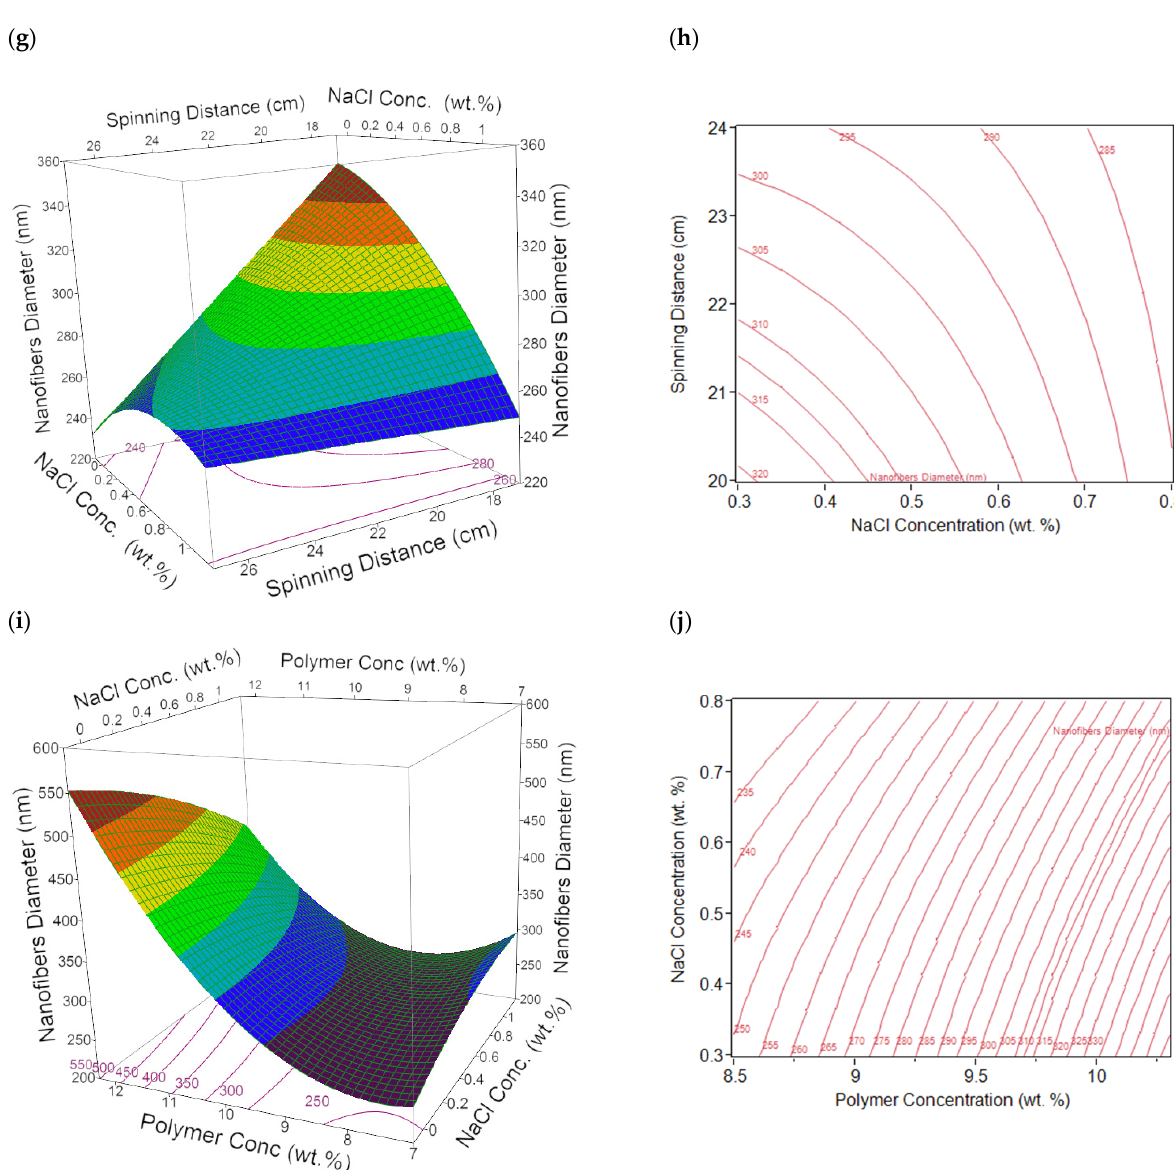
Figure 4. 3D response surface plots ( a , c , e , g , i ) and 2D contour plots ( b , d , f , h , j ) of interaction between the ( a , b ) applied voltage and spinning distance ( VD ); ( c , d ) spinning distance and polymer concentration ( DP ); ( e , f ) flow rate and polymer concentration ( PF ); ( g , h ) spinning distance and concentration of NaCl ( DN ); and ( i , j ) polymer concentration and concentration of NaCl ( PN ).